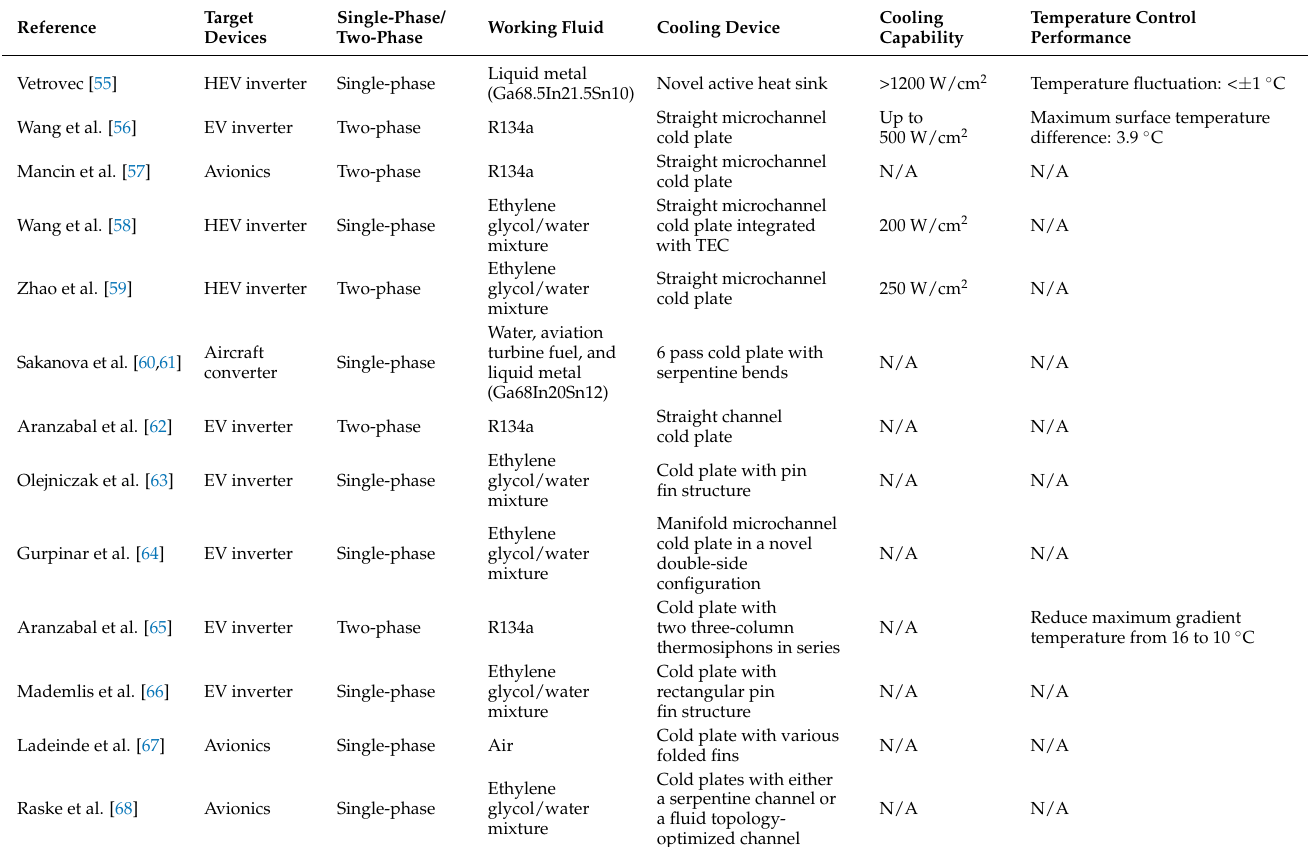
Table 5. Summary of studies focusing on indirect contact cold plate